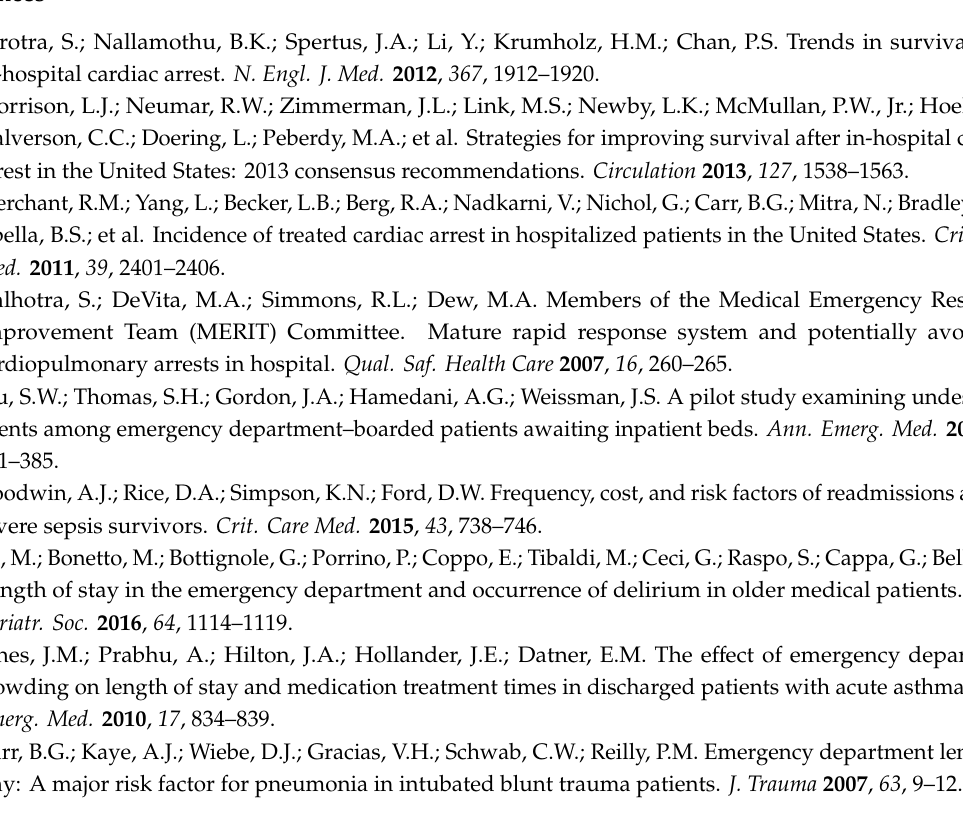
Table S1: Baseline demographic and clinical characteristics of emergency department patients with and without in-hospital cardiac arrest (IHCA) within one hour; Table S2: Baseline demographic and clinical characteristics of emergency department patients with in-hospital cardiac arrest (IHCA) within and after one hour; Table S1: Top 10 categories for ED